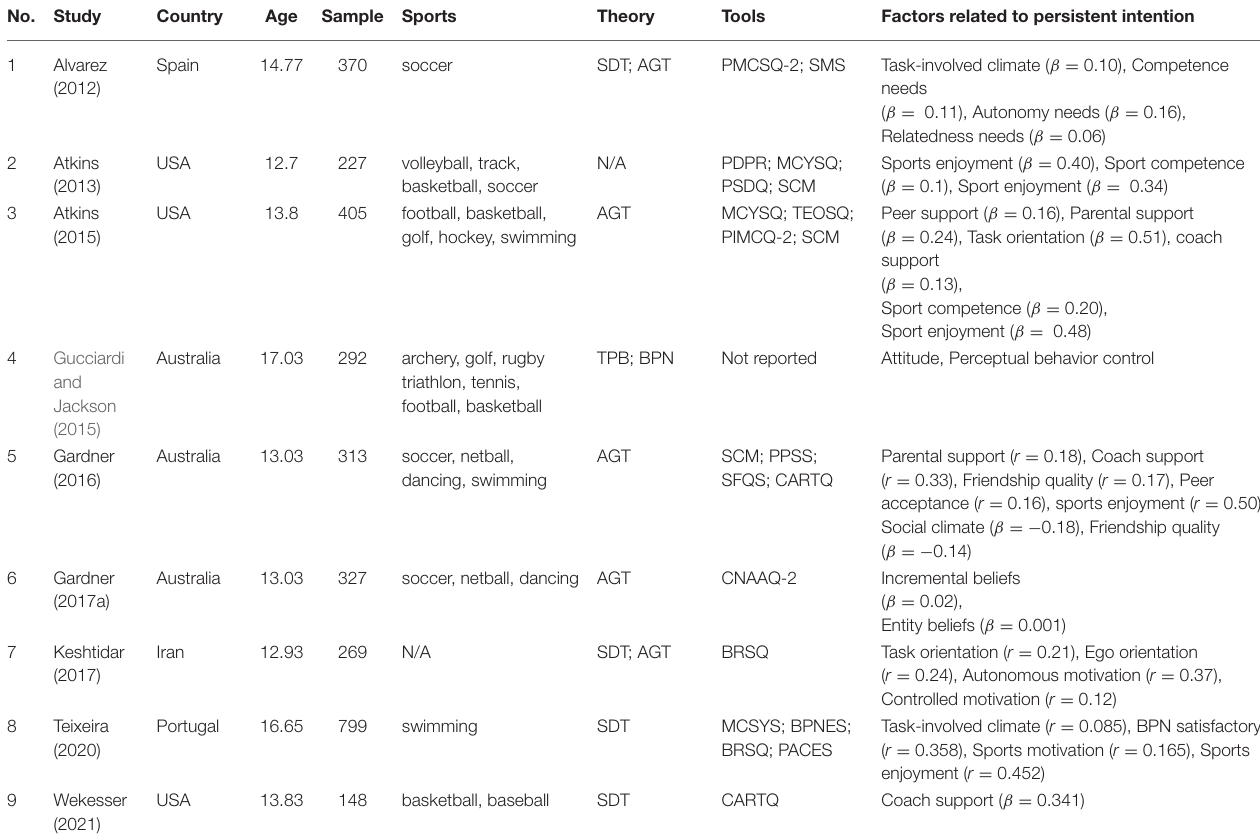
TABLE 2 | Basic characteristics of cross-sectional